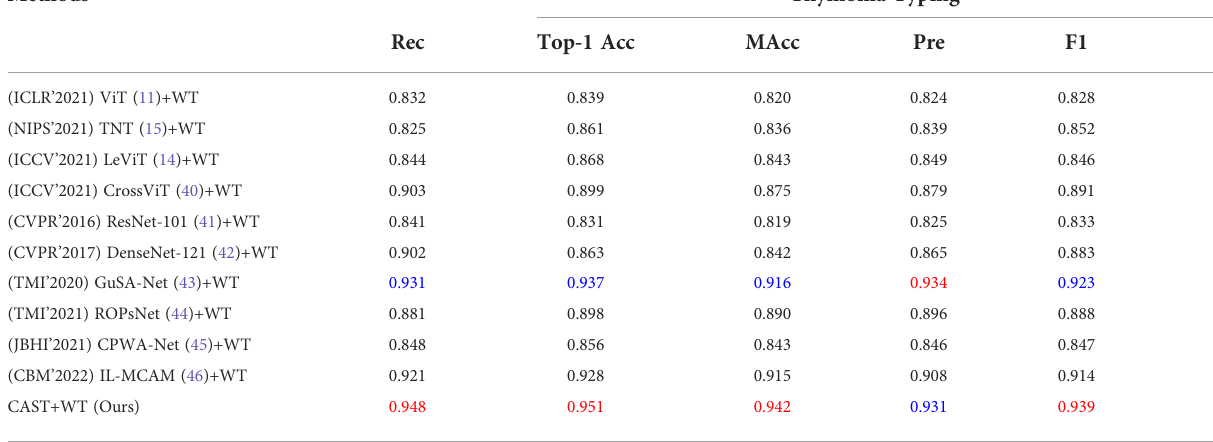
TABLE 4 Quantitative comparisons (Rec, Top-1 Acc, Macc, Pre, and F1) for thymoma typing on the THW dataset. Methods